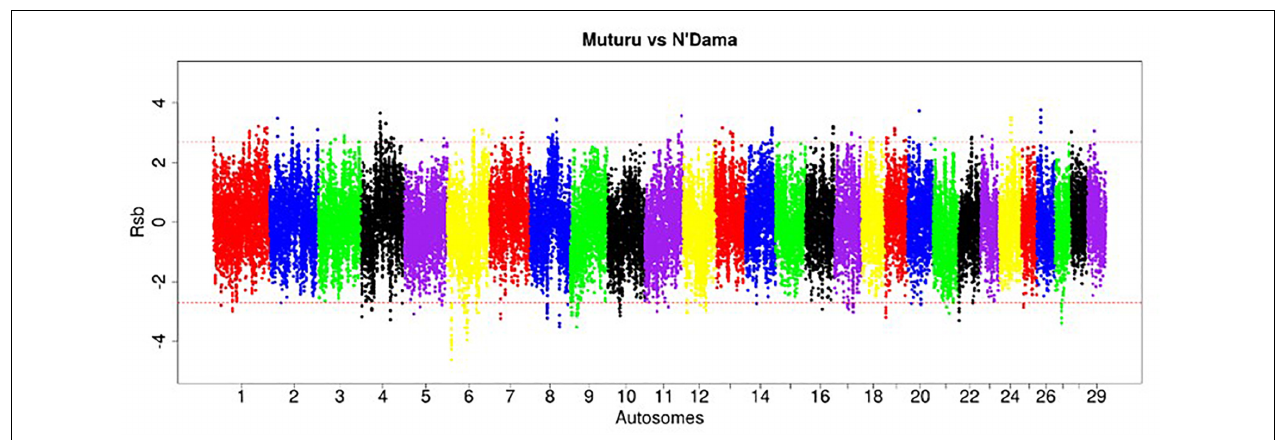
FIGURE 5 | Manhattan plot of the genome-wide distribution of Rsb Muturu – N’Dama. Red dash lines are the threshold of the windows in the top 0.5% Rsb scores.